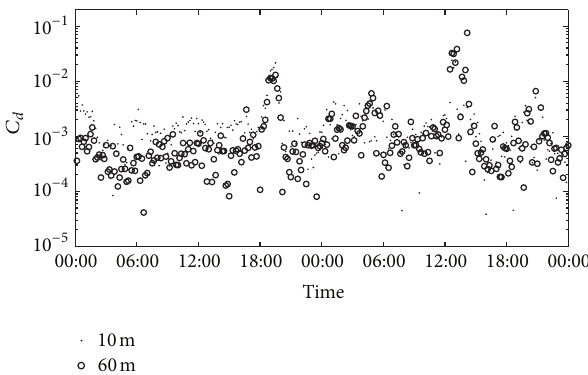
Figure 4: Drag coefficients during typhoon Nuri from 00:00 am on